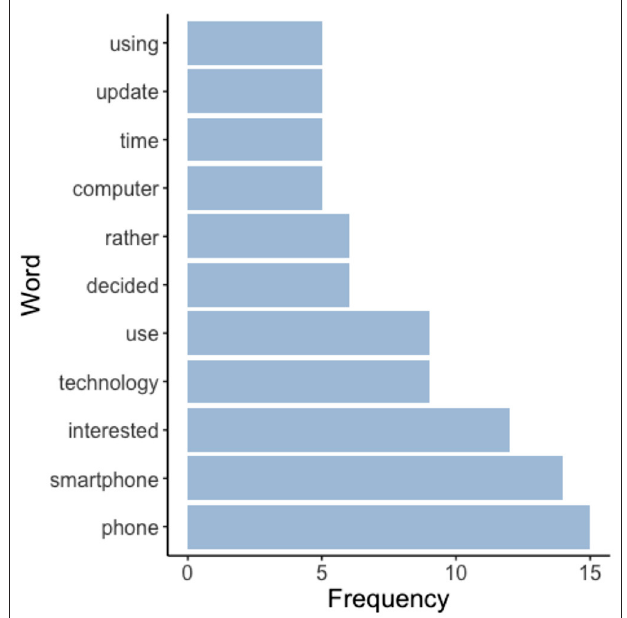
demographics of the individuals who declined to participate in ARC closely resembled those who chose to enroll (see Table 1